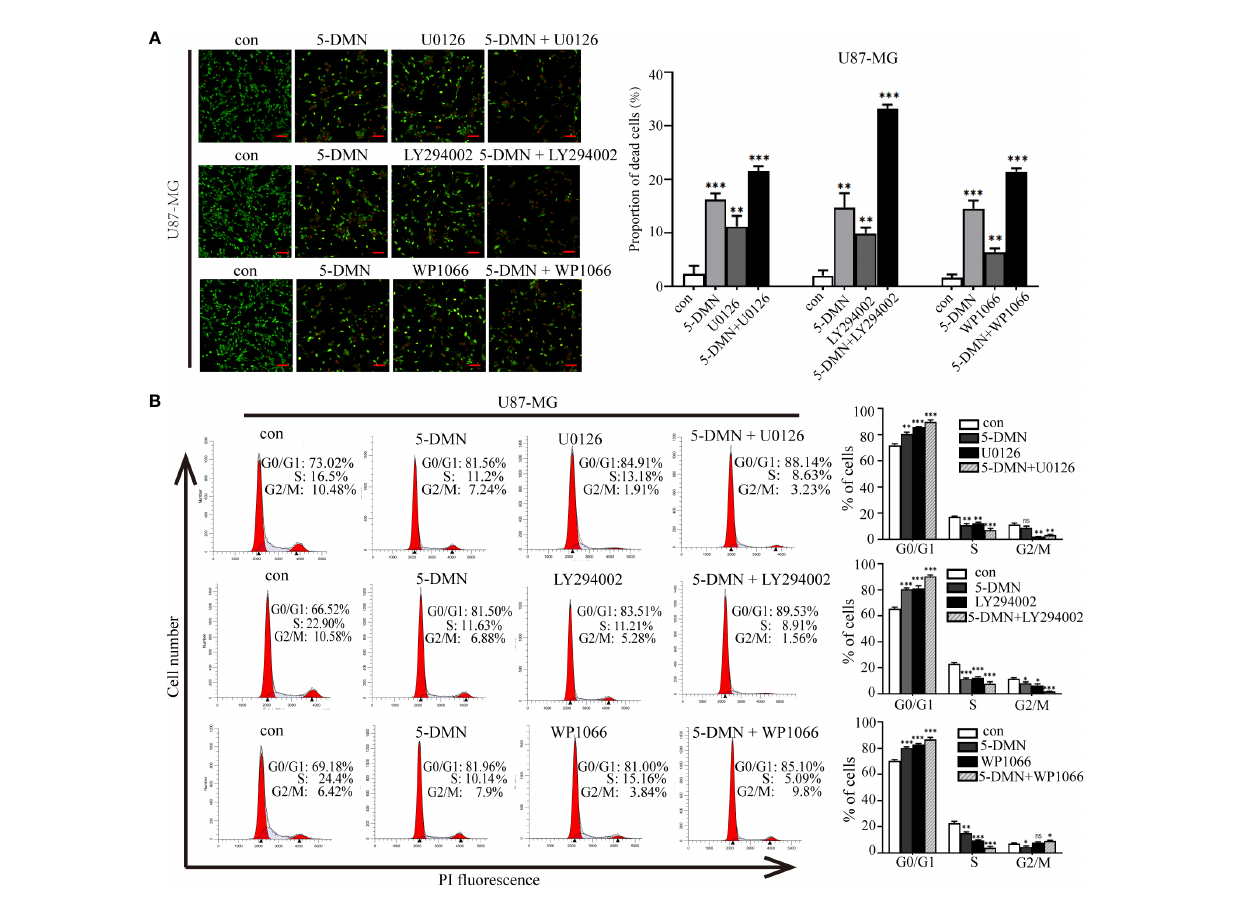
FIGURE 5 Roles of ERK1/2, AKT and STAT3 signaling in cell viability and G0/G1 phase arrest triggered by 5-DMN. (A) Live/dead staining assay of U87-MG cells after 5-DMN (50 m M) with or without the U0126 (15 m M), LY294002 (15 m M) and WP1066 (10 m M) for 48 h. (B) U87-MG cells were treated 5-DMN with or without the inhibitors and cell cycle distribution was determined. *p<0.05, **p<0.01, ***p<0.001 vs. cells in the control group. ns, no signi fi